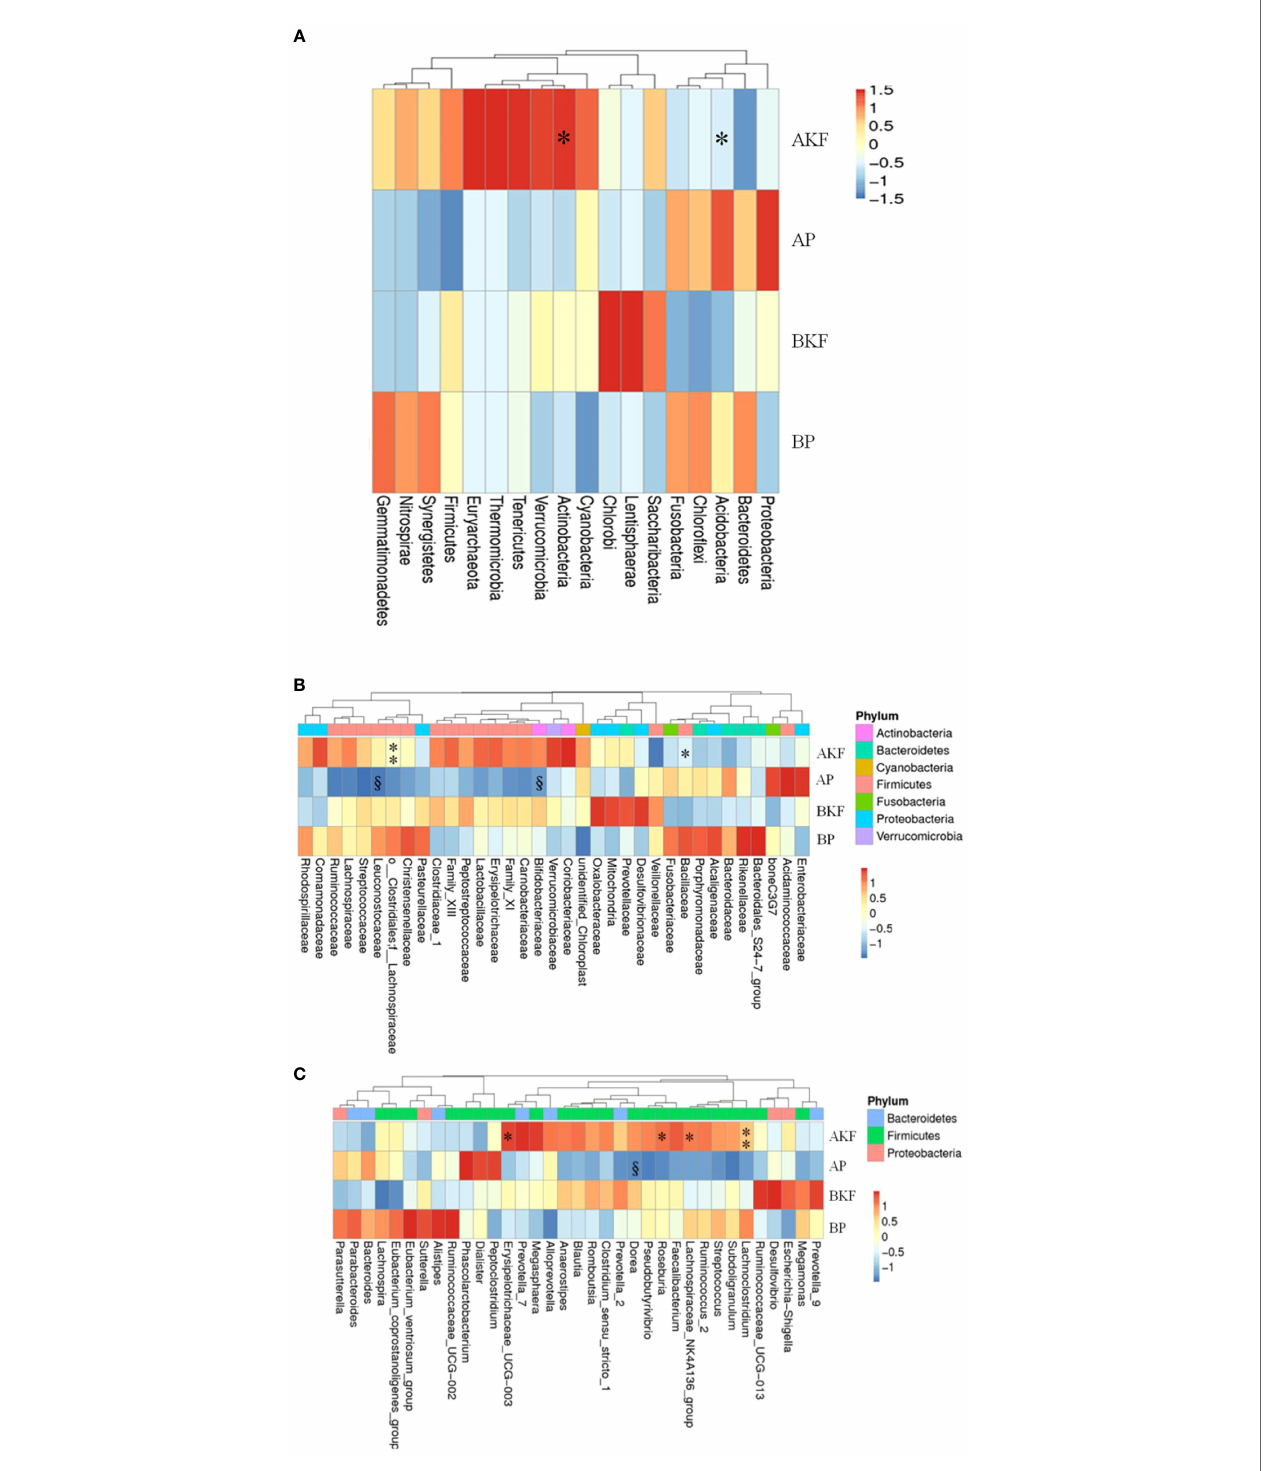
FIGURE 3 | The phyla, family, and genera are signi fi cantly different in different groups. (A) The relative abundance of the fi rst 18 different phyla; (B) The relative abundance of the fi rst 35 different families; (C) The relative abundance of the fi rst 35 different genera. By subtracting the average abundance and dividing by the standard deviation of all samples, the abundance pro fi le is converted to a Z-score. When the row abundance is lower than the average, the Z score is negative (shown in blue). § P <0.05 with BP and *p <0.05, **p <0.01 with